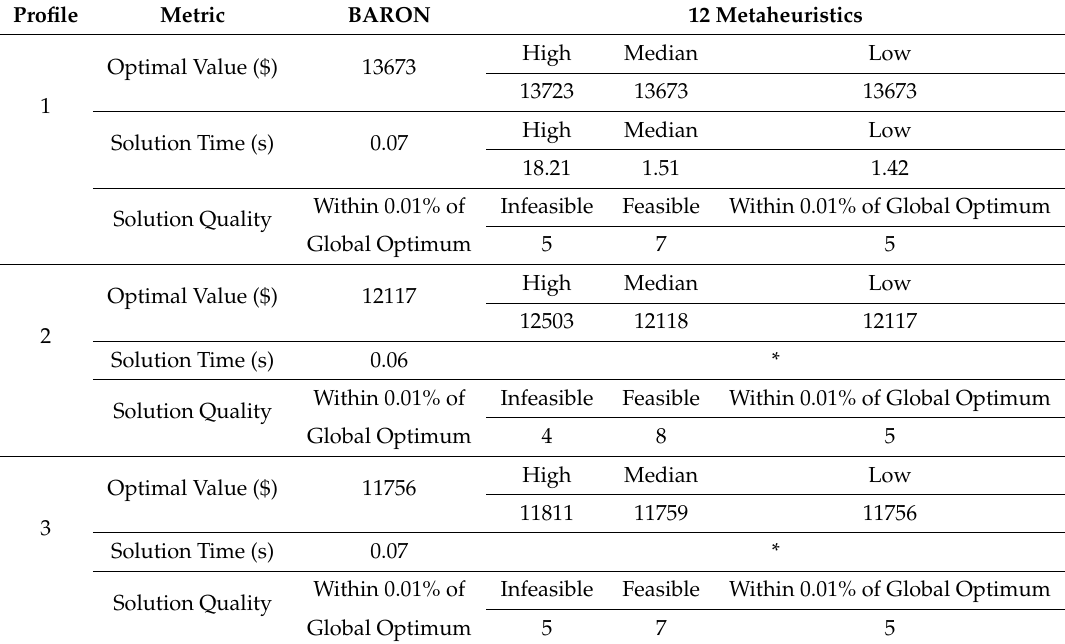
Table 6. Comparison of BARON solver versus past metaheuristic algorithm performance for test instance 2. Please note that optimal values reported for metaheuristics are only for feasible solutions.